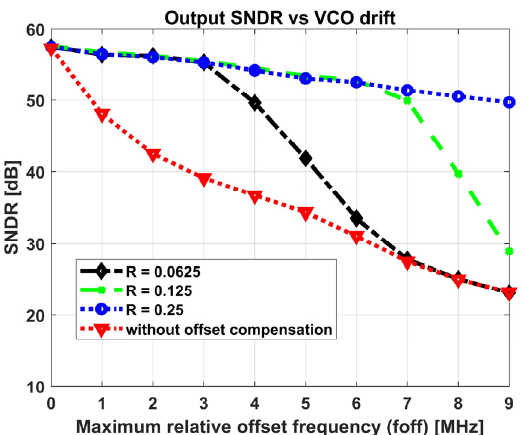
Figure 5. Variation in the simulated output SNDR with the magnitude of maximum relative offset frequency of the two VCOs.